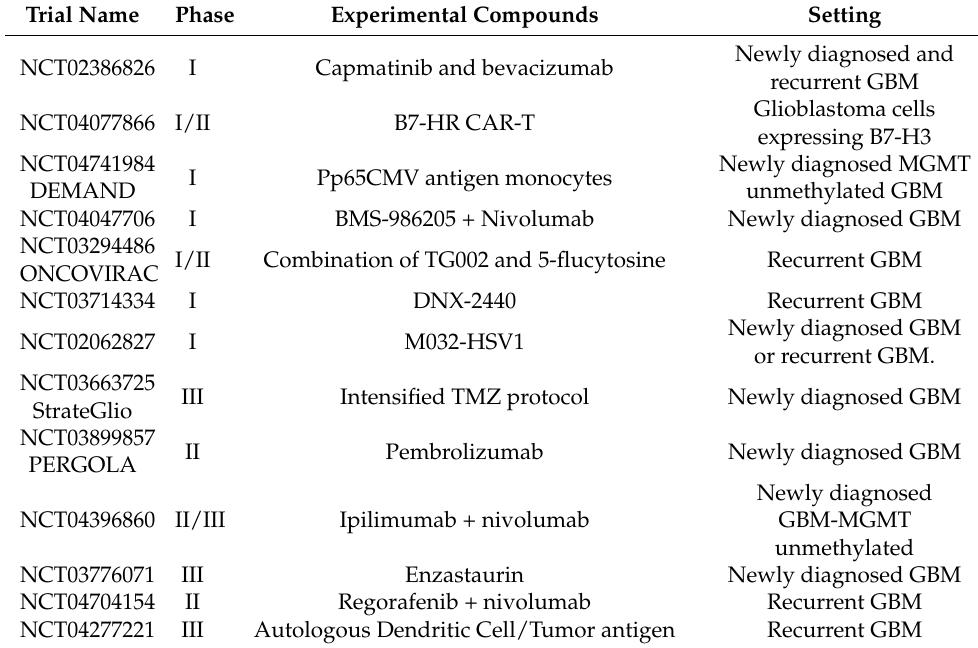
Table 1. Clinical trials cited in the text. MGMT: methylation of the O(6)-methylguanine-DNA methyltransferase, TMZ: